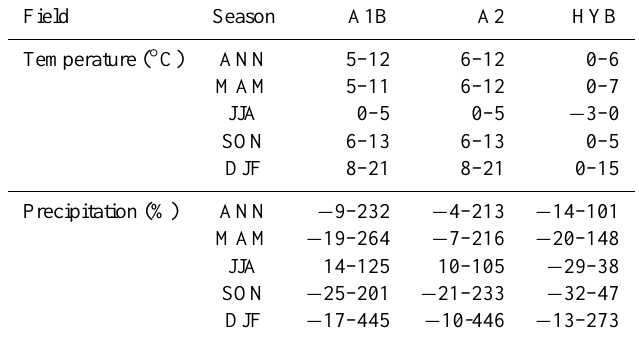
Fig. 8. Summer anomalies of sea ice concentration (%), turbulent heat flux (Wm − 2 ), surface air temperature ( ◦ C) and total precipitation (%) of the A1B, A2 and HYB from the 20C3M simulation. Apart from sea ice, anomalies are significant at the 95% level using a student’s t -test. Table 3. Annual (ANN), Spring (MAM), Summer (JJA), Autumn (SON) and winter (DJF) estimates of area averaged temperature and total precipitation change on Svalbard for A1B, A2 and HYB simulations, compared to 20C3M control experiment. The intervals expresses the geographical spread of change, not projection